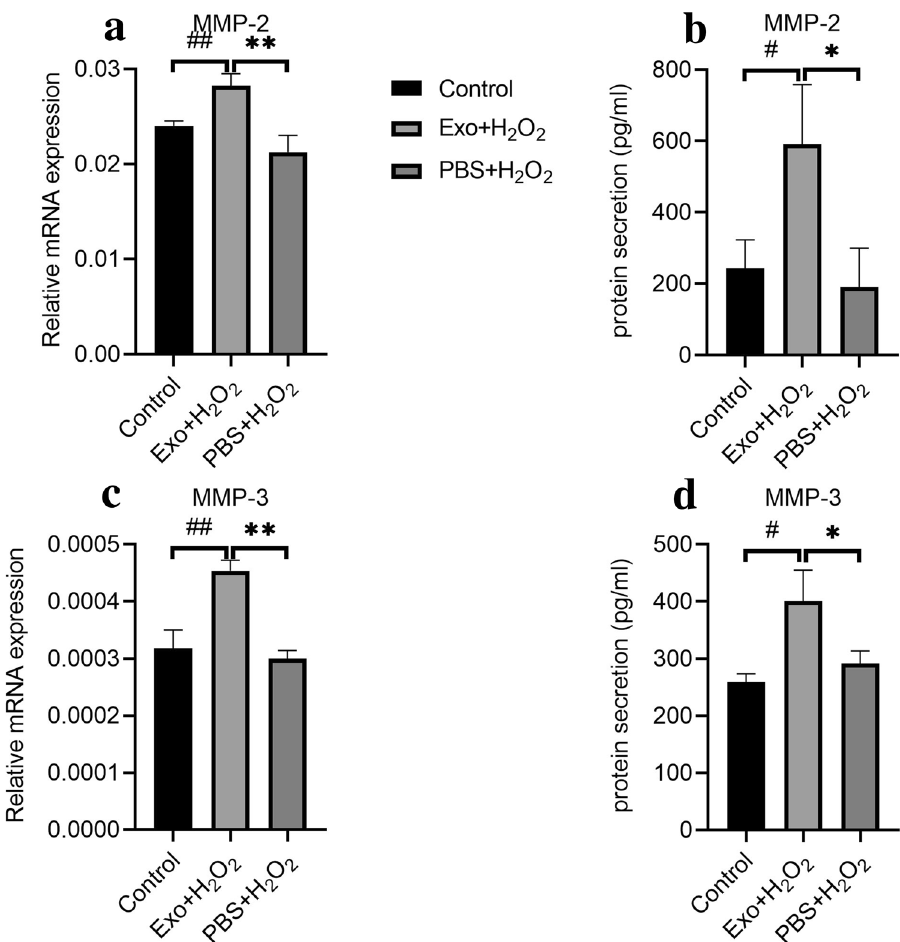
Figure 6. Pretreatment of hBMSC-derived exosome up-regulated the expression of matrix metalloproteinases in hTMCs when exposed to H 2 O 2 . HTMCs were pretreated with hBMSC-derived exosomes or PBS for 24 h, then exposed to H 2 O 2 (0.1 mM) for 6 h, and a blank control group cultured with medium containing exosome-free serum. Then, hTMCs were assayed by RT-PCR to assess the mRNA expression of MMP-2 ( a ) and MMP-3 ( c ). Gene expression levels were normalized to GAPDH and presented as relative ratios. Total hTMC supernatants were analyzed for MMP-2 ( b ) and MMP-3 ( d ). n = 3 for each condition. A P value was obtained by a two-tailed unpaired t-test. *P < 0.05; **P < 0.01 compared to PBS + H 2 O 2 group. # P < 0.05; ## P < 0.01 compared to control. Data were presented in Supplementary Tables S4 and